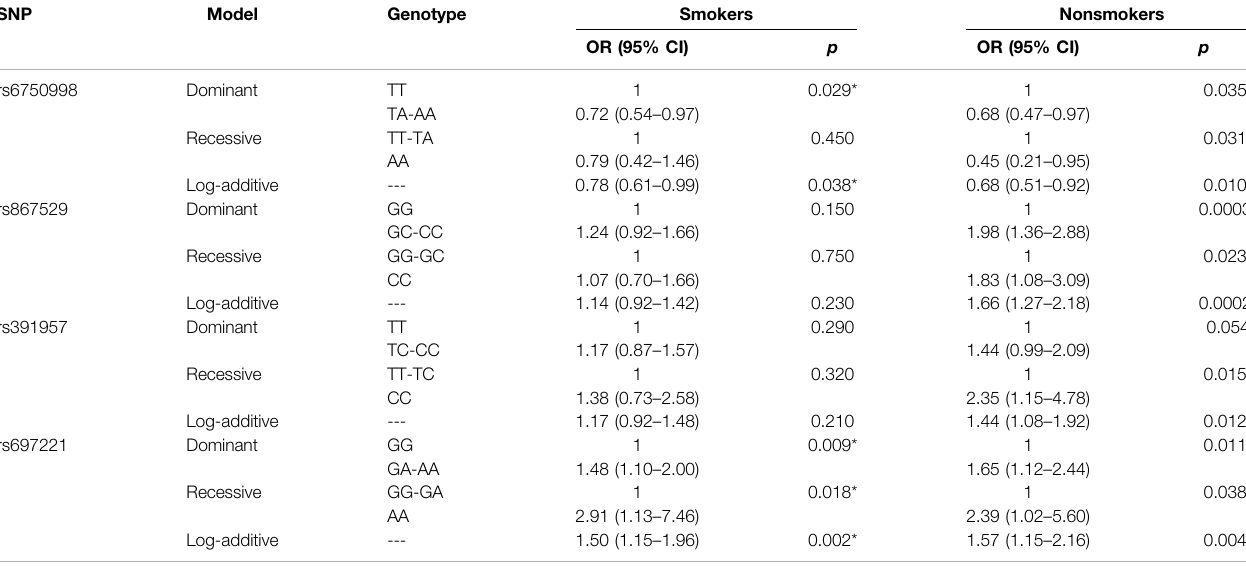
TABLE 6 | Association between SNPs and risk of lung cancer in smokers and nonsmokers. SNP